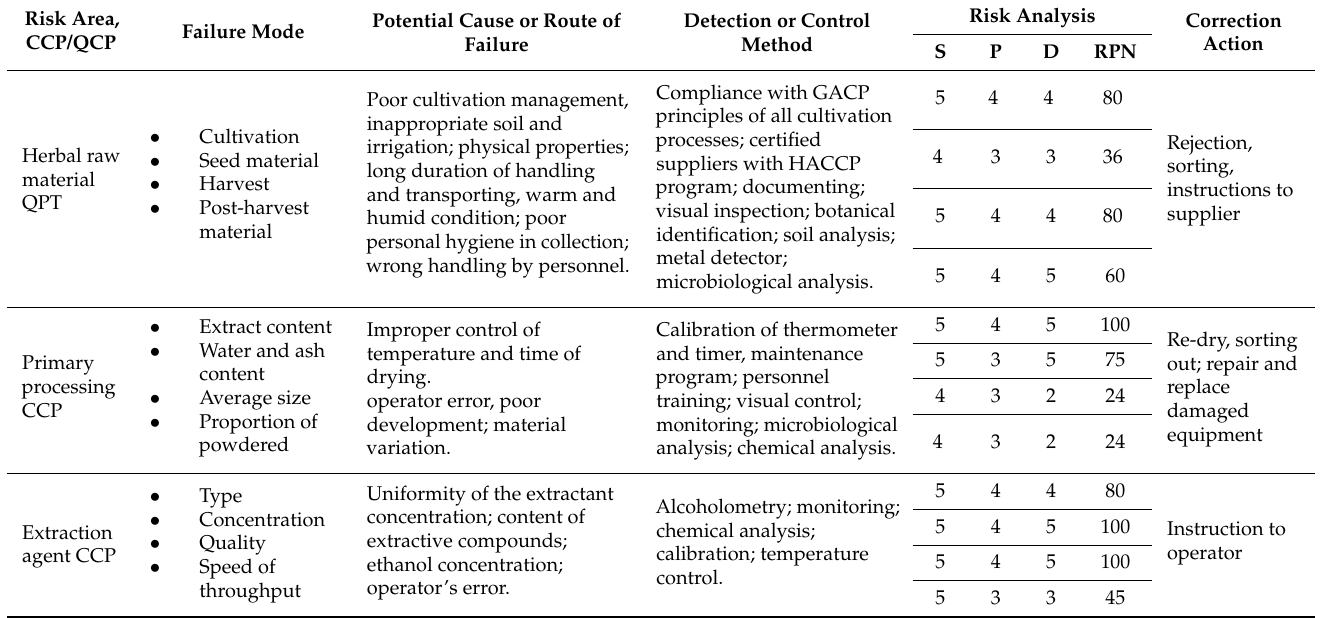
Table 1. Failure mode and effect analysis of Crocus sativus perianth extract manufacturing